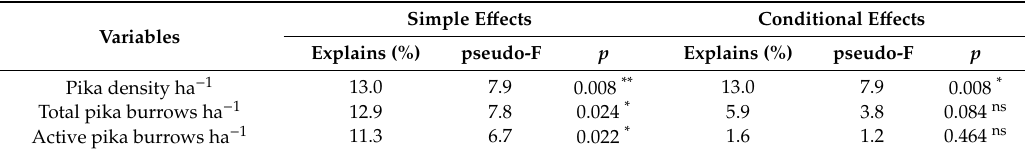
Figure 10. Relationships between pika density and species richness ( a ), Shannon index ( b ), Simpson index ( c ) and Pielou’s J index ( d ). The shaded area shows the 95% confidence interval of the fit. ASwM, AM, AStM and AS indicate alpine swamp meadow, alpine meadow, alpine steppe meadow and alpine steppe, respectively. Table 4. Monte Carlo permutation tests of the simple effects and conditional effects of pika density and burrows on vegetation species richness of functional groups. *, p < 0.05; **, p < 0.01; ns, no significant difference.